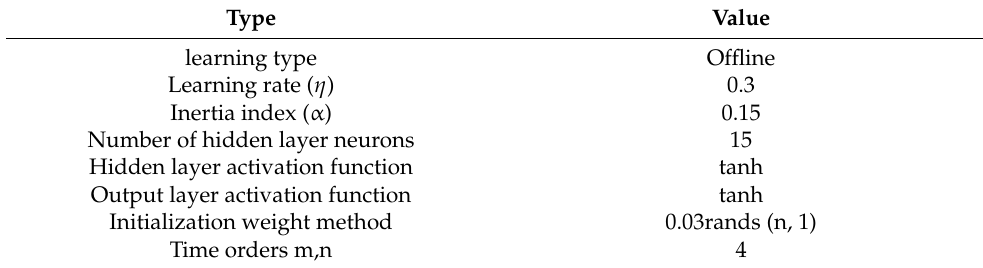
Table 2. Parameters of neural network ANN2.